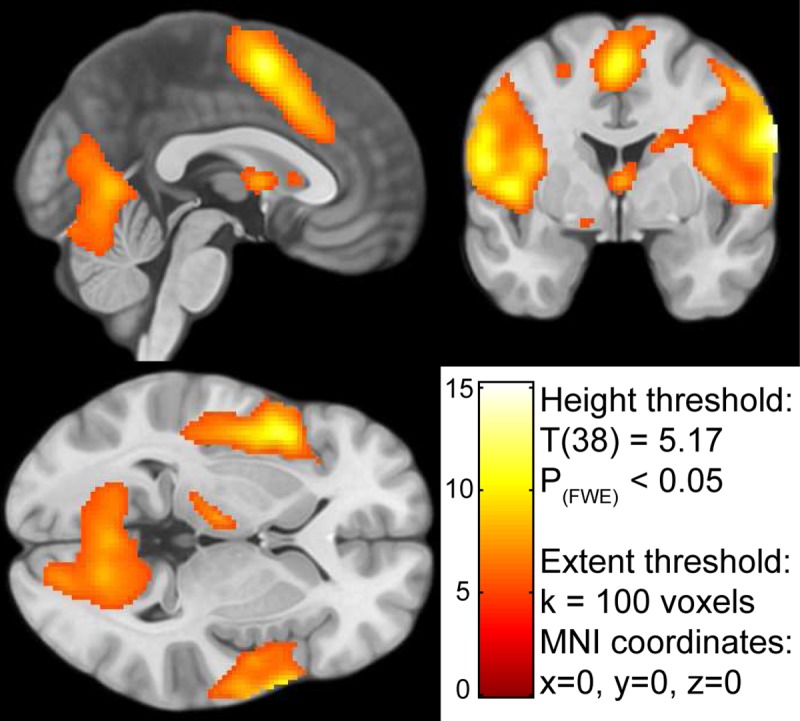
Result for the SPM mass univariate second level analysis.The result indicates the activated voxels in response to tasting a flavor during the fMRI scan. The color-coding of the intensity map is based on the T value generated by the contrast [Taste & Swallow—baseline]. The contrast map is available in the supplementary materials.